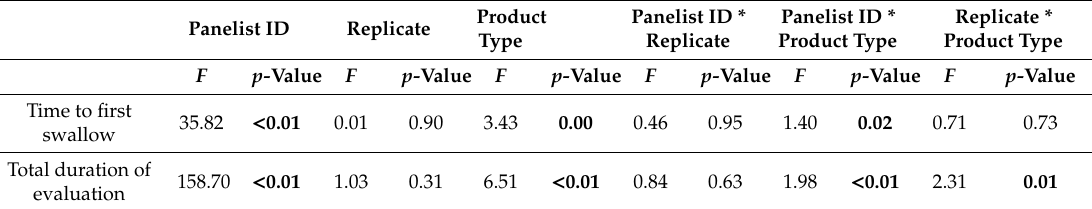
Table 5. Results of the three-way ANOVAs (panelist ID, replicate, and product type as fixed e ff ects + their first-order interactions) examining the e ff ects of beverage type (all 12 beverages) on the time to the first instance of swallowing and the total duration of evaluation using the mono-intake TDS profiling data (total degrees of freedom: 359; residual degrees of freedom: 154). Significant p -values are in bold ( α = 0.05). Product Panelist ID * Panelist ID * Replicate * Panelist ID Replicate Type Replicate Product Type Product Type F p- Value